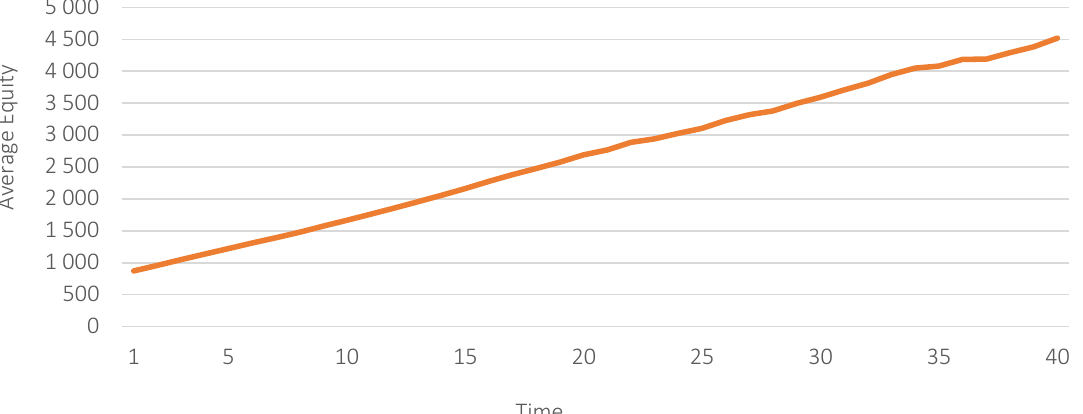
Figure 15. Evolution of average companies’ equity in Islamic LBO market